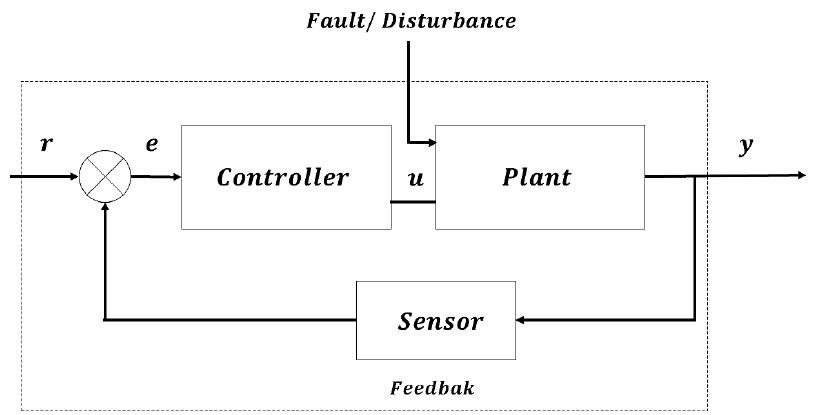
Figure 1. Block diagram representing the dynamic system under the presence of faults. Here, r is the reference signal, u is the control input, y is the output and e is the regulation or tracking